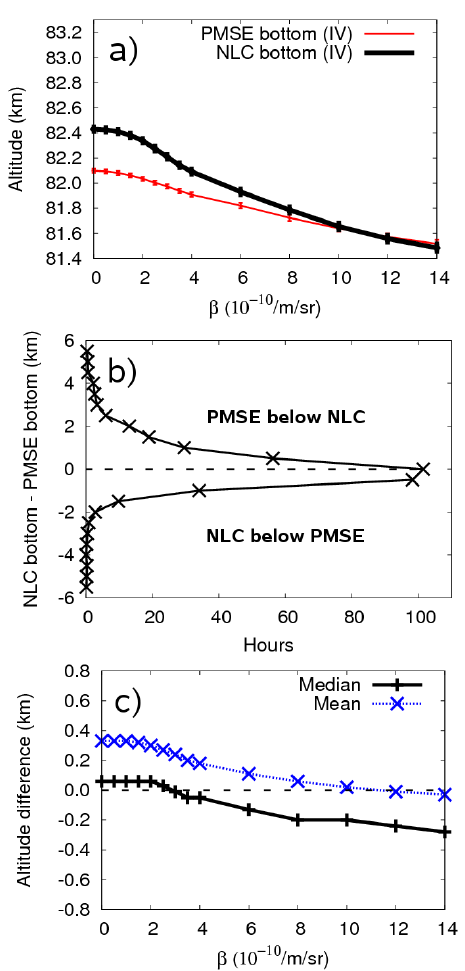
Fig. 6. (a) Average bottom altitudes of PMSE and NLC in case of simultaneous observations of NLC and PMSE (case IV) as a func- tion of the threshold β thr . (b) Distribution of separation of PMSE and NLC bottom altitudes for β thr = 4 × 10 − 10 m − 1 sr − 1 of com- bined observations. (c) Mean and median of the distribution in (b) as a function of β thr .